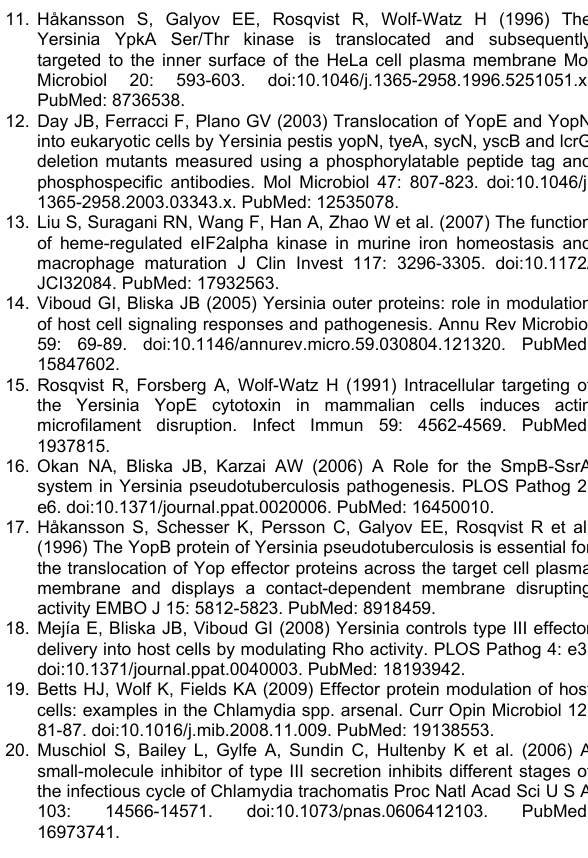
Figure S4. Hri -/- cells are highly resistant to long-term Listeria infection. Hri +/+ and -/- MEFs were infected